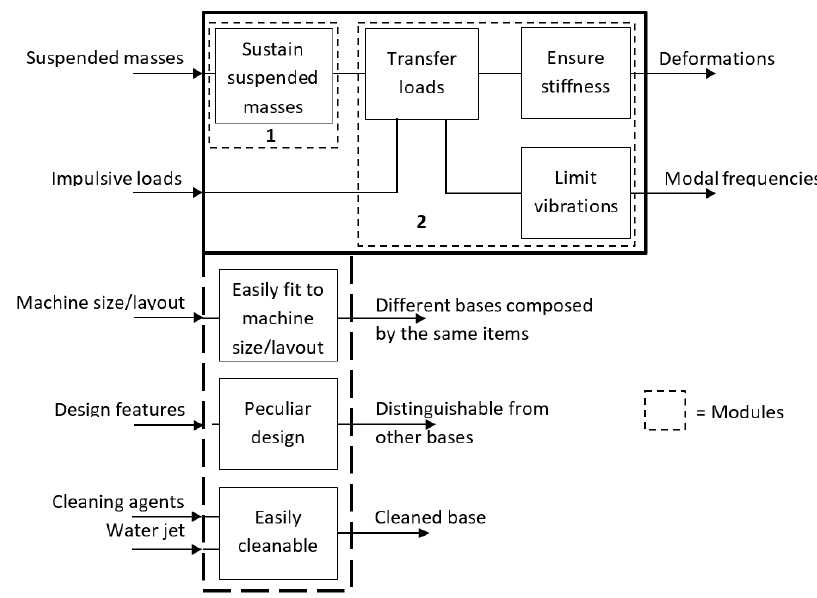
Figure 4. Functional decomposition of the base.